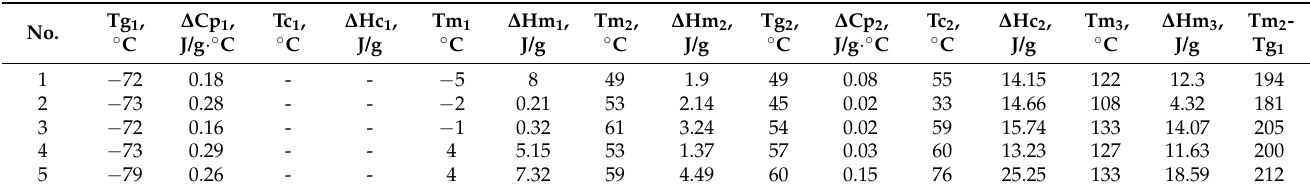
Table A1. Thermal properties of the TPEs of series